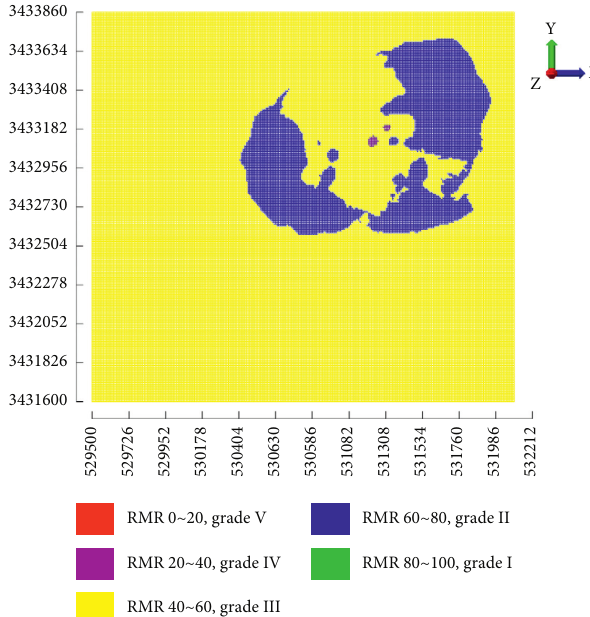
Figure 13: Current status map of horizontal grading distribution of − 540m horizontal rock